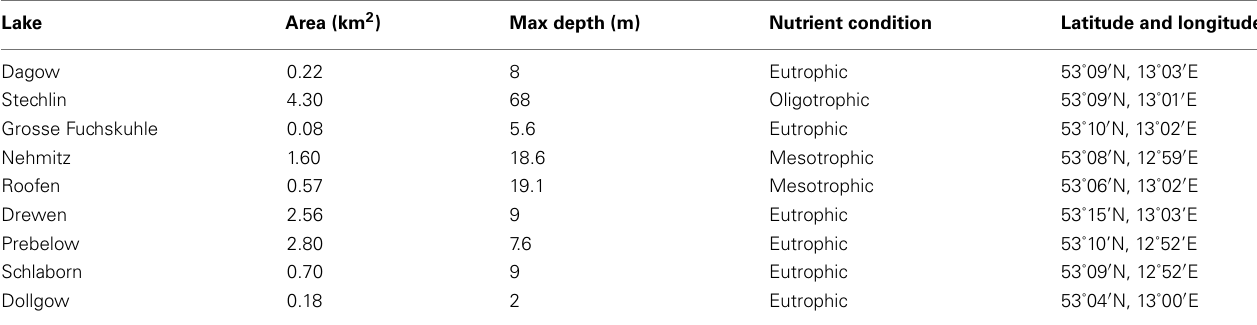
Table 1 | Limnological characteristics for sampled lakes.